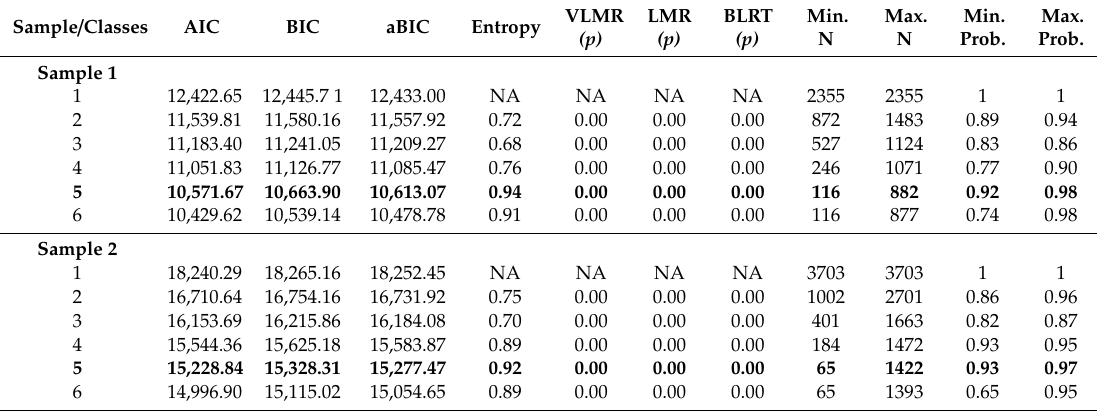
Table A1. Detailed results for the selection of the Latent Profile Analyses solution. Sample /